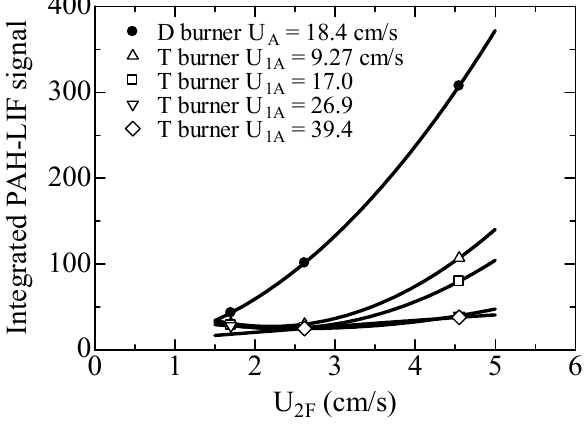
Figure 7. Integrated PAH-LIF signal for total PAH amount at different fuel flow velocity.